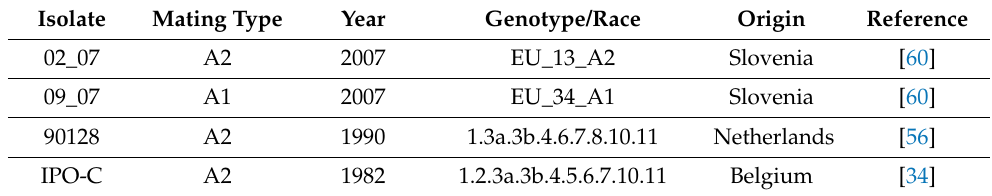
Table 3. Characteristics of Phytophthora infestans isolates used in this